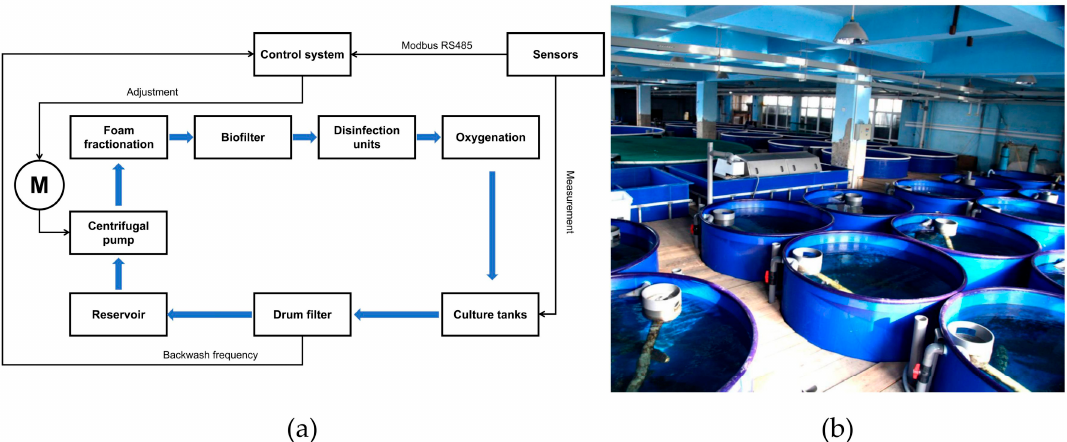
Figure 1. The experimental recirculating aquaculture system: ( a ) the schematic of the experimental RAS control process; ( b ) the RAS in Dalian Huixin Titanium Equipment Development Co., Ltd.